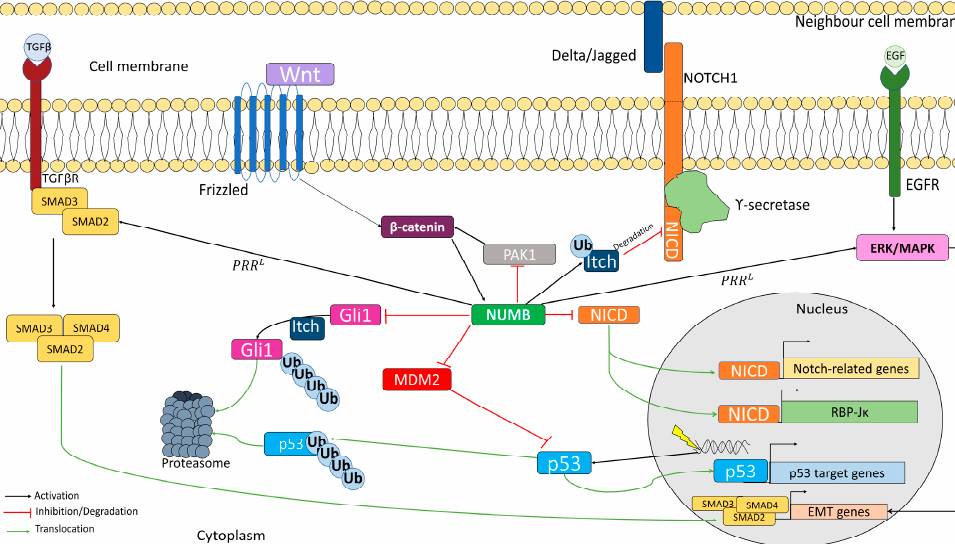
Figure 3. NUMB acts as an adaptor protein in multiple signaling pathways. NUMB inhibits NOTCH signaling by interacting with NICD. Additionally, the interaction between NUMB and MDM2 increases p53 stability, allowing transcription of genes related to DNA-damage repair. Furthermore, the PRR L NUMB isoform promotes ERK/MAPK signaling and the formation of a SMAD complex, leading to transcription of genes related to EMT. In addition, NUMB promotes the ubiquitination and subsequent degradation of both NUMB and ITCH through GLI1.